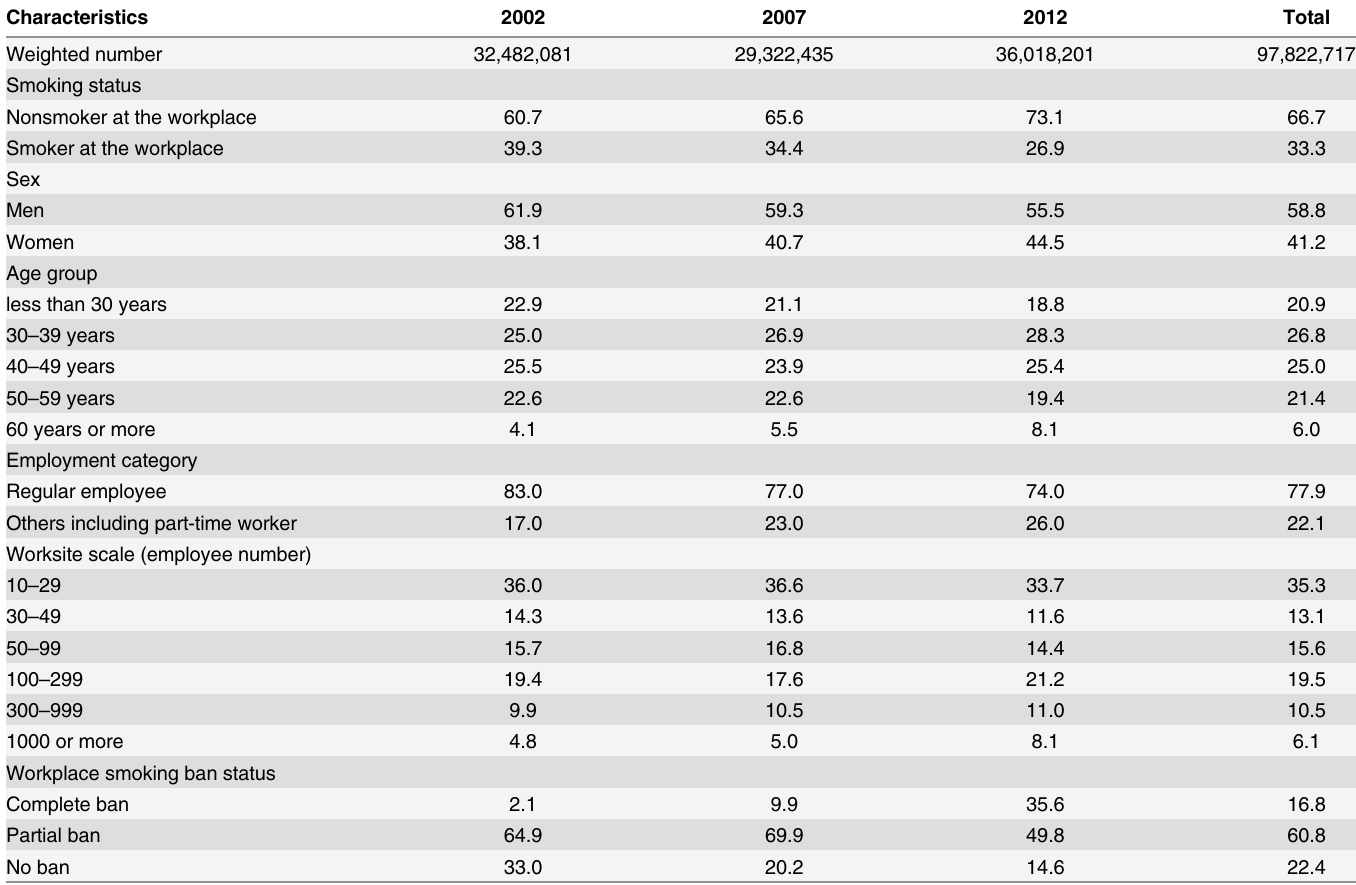
Table 2. Basic characteristics of study subjects in percent (weighted